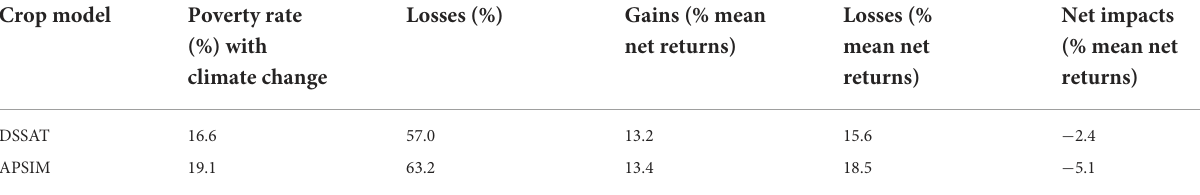
TABLE 3 Aggregated gains and losses with CCSM4 GCM (without adaptation and with trend) of DSSAT and APSIM. Crop model